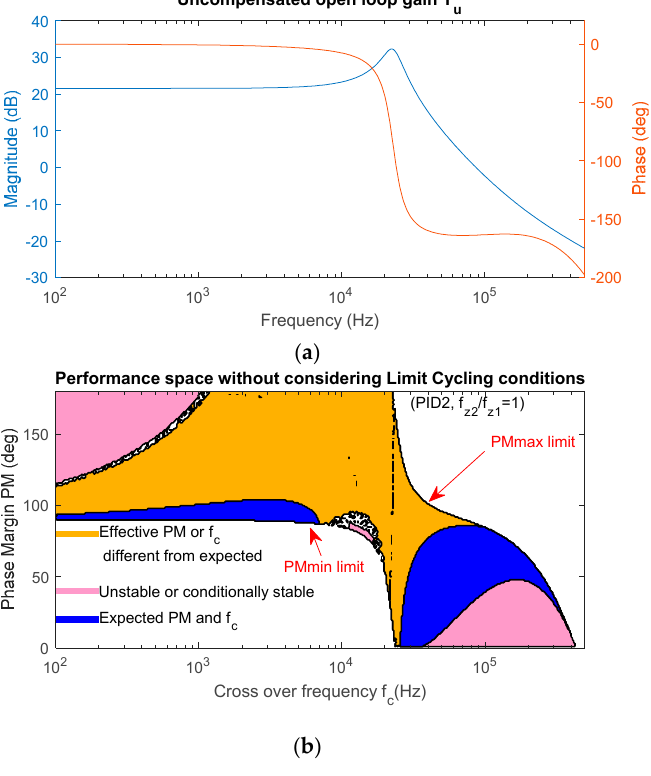
Figure 6. ( a ) Bode plot of the uncompensated transfer function, Tu; ( b ) performance space for a PID1 compensator, without considering limit cycling conditions.